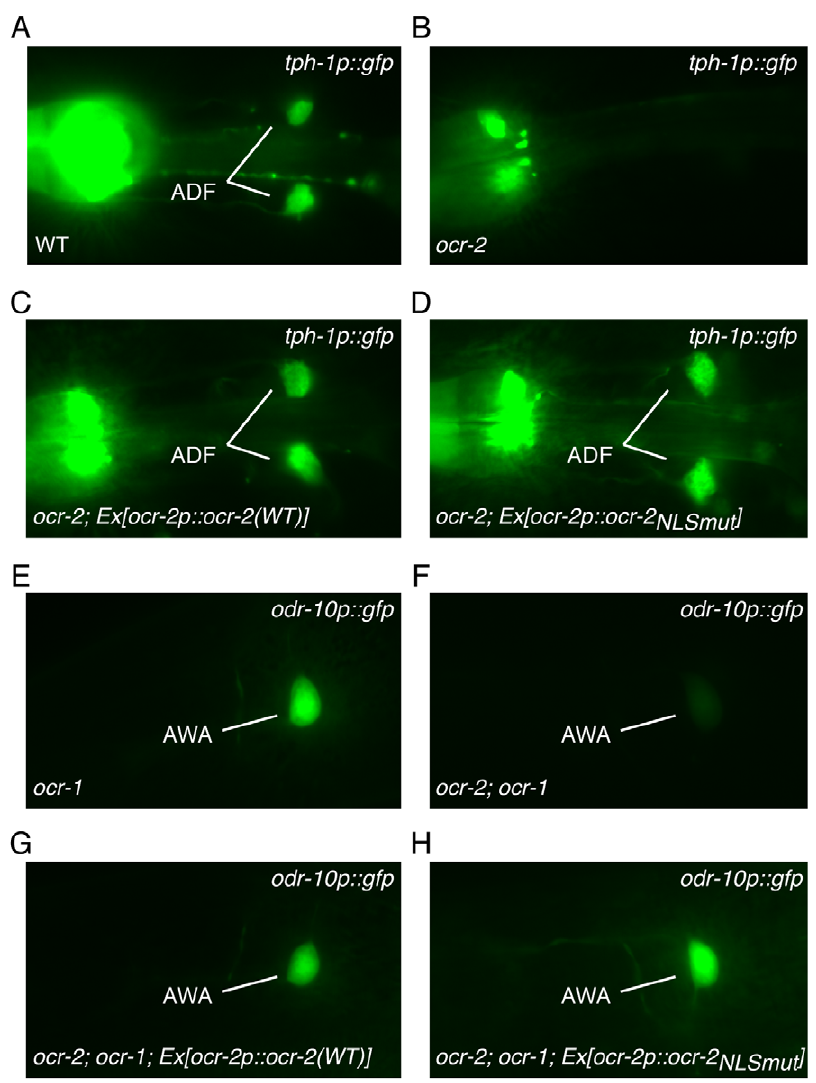
Figure 5. OCR-2 regulates expression of tph-1 and odr-10 independently of the NLS. (A–D) The OCR-2 NLS is not required for tph-1::gfp expression. (A) TPH-1 is a serotonin biosynthetic enzyme and, as previously described [11], a tph-1p::gfp transcriptional reporter is expressed in the ADF and NSM head neurons. The ADF neurons are indicated. The NSM neurons are seen in the left of each panel. (B) OCR-2 has been reported to modulate transcription of tph-1 [11], and ocr-2(ak47) null mutants have reduced expression of tph-1p::gfp in the ADF neurons. Using the ocr-2 promoter, either (C) the wild-type OCR-2 channel ( ocr-2p::ocr-2 ), or (D) the channel in which the basic residues of the NLS had been mutated to alanine ( ocr-2p::ocr-2 NLSmut ), was re-introduced into ocr-2(ak47) mutant animals. Both channels restored tph-1p::gfp expression in ADF. (E-H) The OCR-2 NLS is not required for odr-10::gfp expression. ODR-10 is a G protein-coupled receptor and an odr-10p::gfp transcriptional reporter is expressed solely in the AWA head neurons [5]. (E) Expression of odr-10p::gfp in ocr-1(ak46) null mutants is indistinguishable from wild-type animals (and [5]). (F) ocr- 2(ak47);ocr-1(ak46) double mutants have drastically reduced expression of odr-10p::gfp (and [5]). Using the ocr-2 promoter, either (G) the wild-type OCR-2 channel ( ocr-2p::ocr-2 ), or (H) the channel in which the basic residues of the NLS had been mutated to alanine (ocr-2p::ocr-2 NLSmut ) , was re- introduced into ocr-2(ak47);ocr-1(ak46) mutant animals. Both channels restored odr-10p::gfp expression in AWA. $ 2 independent transgenic lines were examined for each construct, n $ 40 transgenic animals.